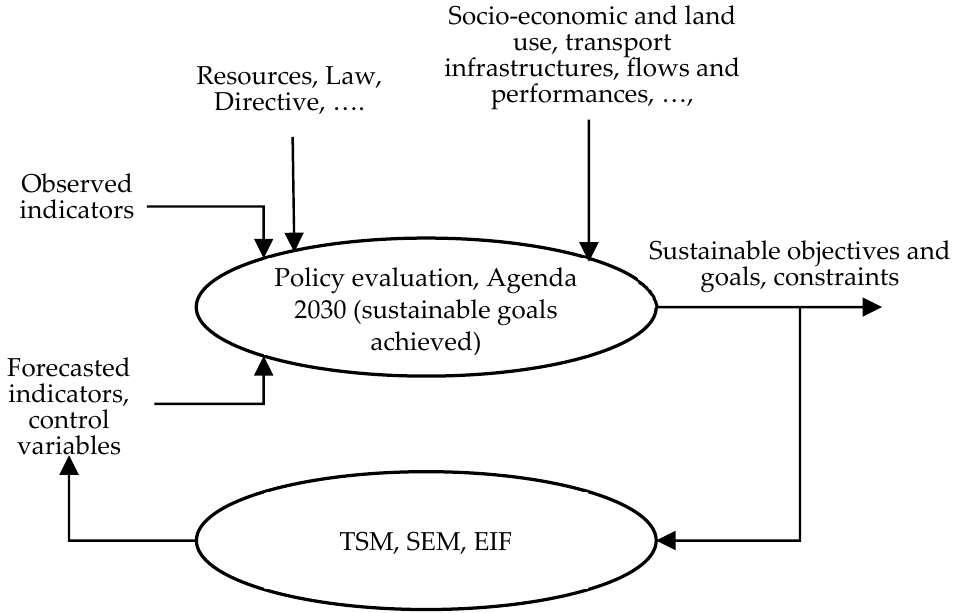
Figure 4. SMaaS—Sustainable policies and